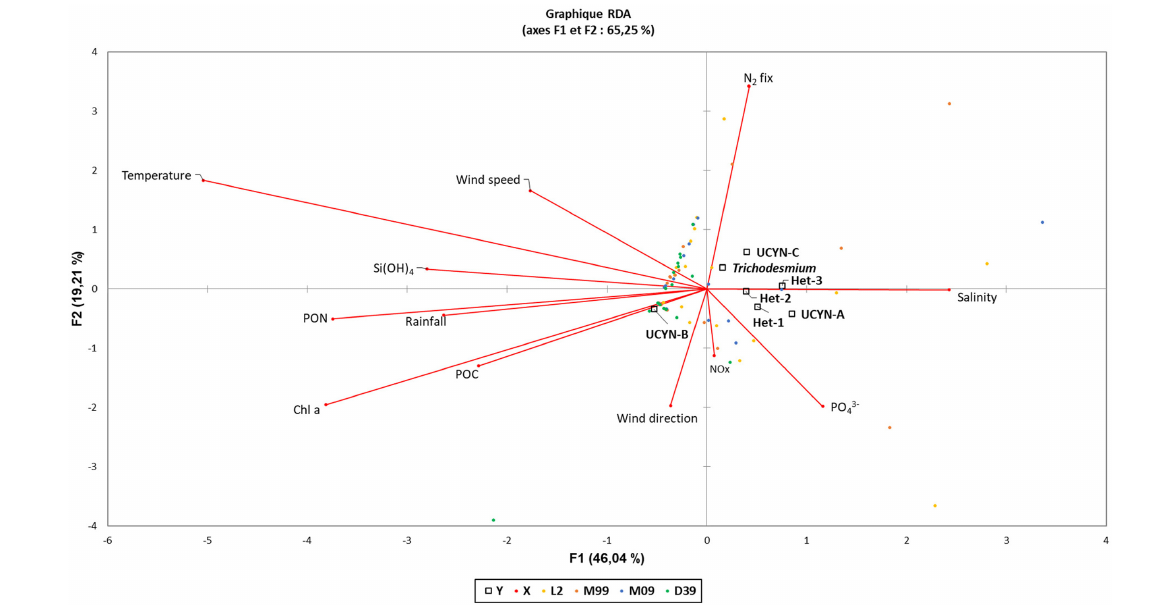
Frontiers in Marine Science |